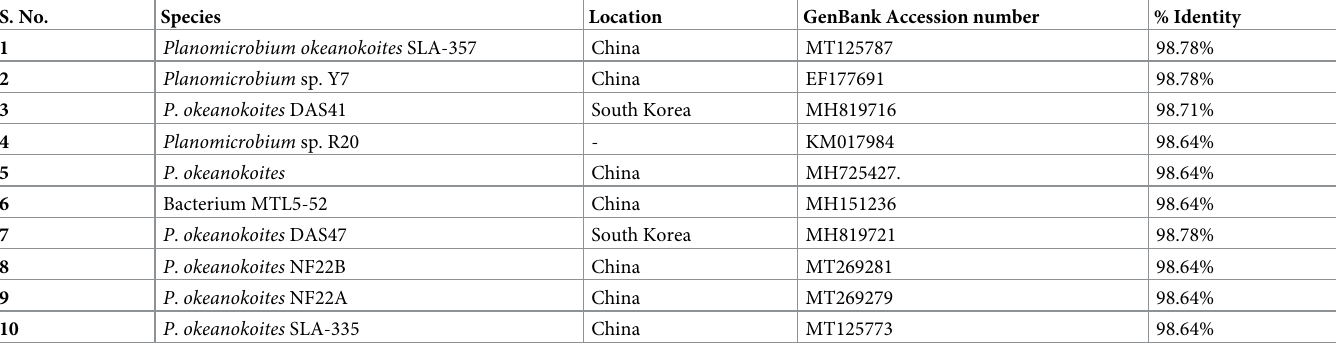
Table 4. Top 10 BLASTn hits of the bacterial sequence.